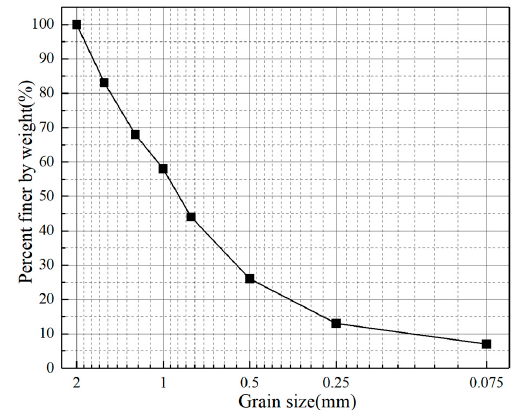
Figure 5. Particle gradation curve of test soil.